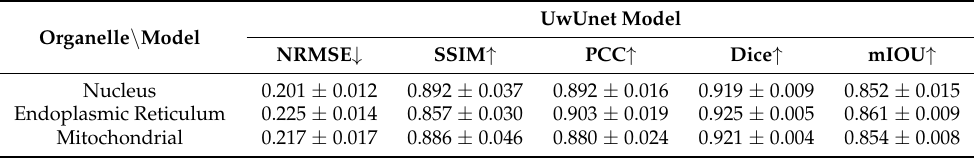
Table 2. The prediction result measures of protein subcellular localization using the UwUnet model. Here, ↓ indicates that the lower the index value, the better the performance; ↑ indicates that the higher the index value, the better the performance of the model.